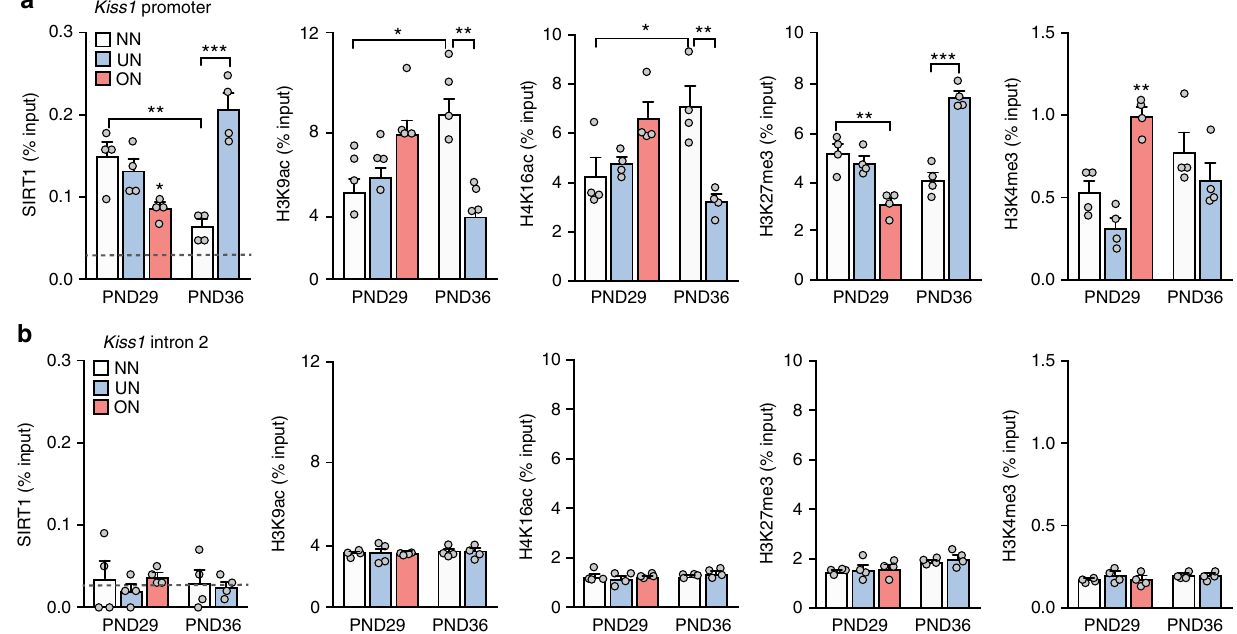
Fig. 7 Sirt1 regulates the chromatin architecture at the Kiss1 promoter. a Chromatin immunoprecipitation (ChIP) assays showing the association of SIRT1, H3K9Ac, H4K16Ac, H3K27me3 and H3K4me3 to the Kiss1 promoter in the MBH of female rats fed normally (NN) or subjected to postnatal nutritional manipulation (ON: overnutrition, UN: undernutrition). b Lack of changes in SIRT1, H3K9Ac, H4K16Ac, H3K27me3, and H3K4me3 association to intron 2 of the Kiss1 gene. The results are expressed as % of the signal generated by input DNA. The bar histograms represent the mean ± SEM. * p < 0.05; ** p <